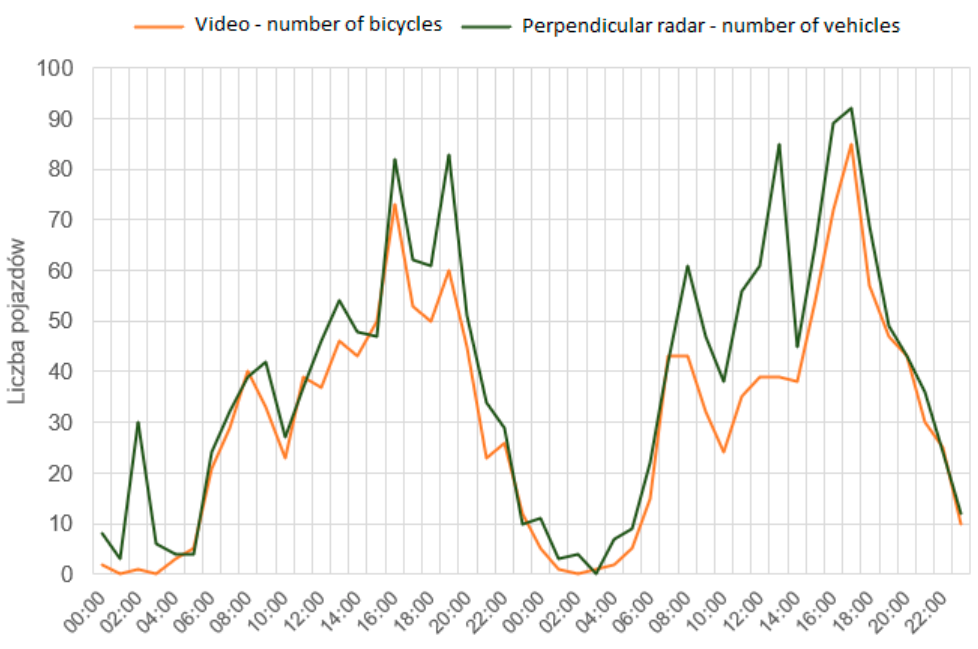
Figure 12. Comparison of the number of vehicles recorded by the perpendicular radar with the actual number of bicycles (the measuring station at Ś wi ę tokrzyska street) (own study).